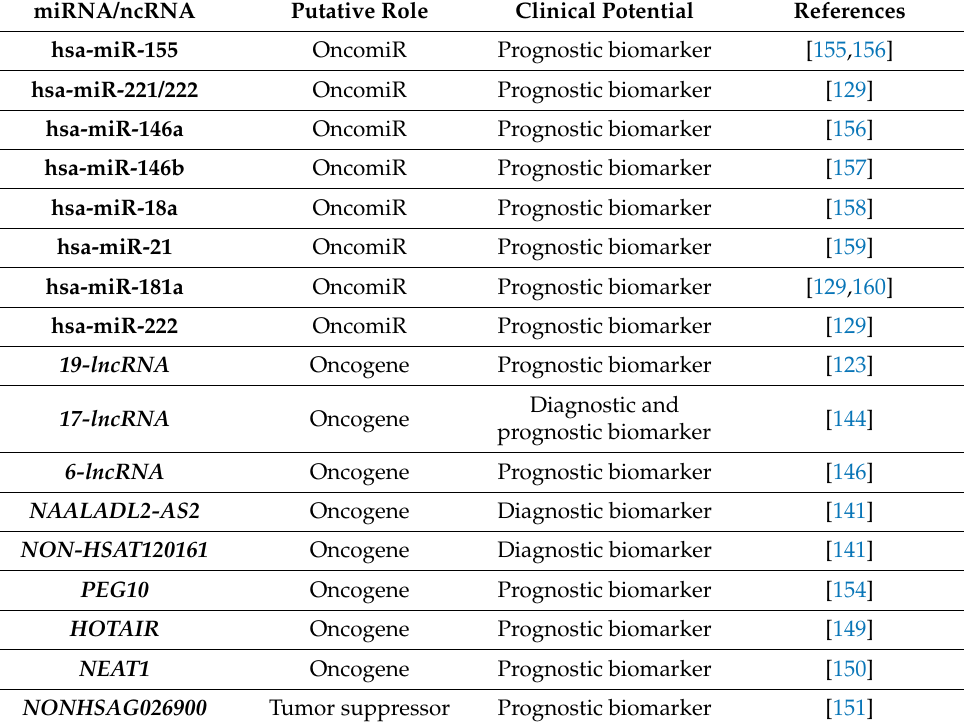
Table 3. Clinical potential of miRNAs/lncRNAs in